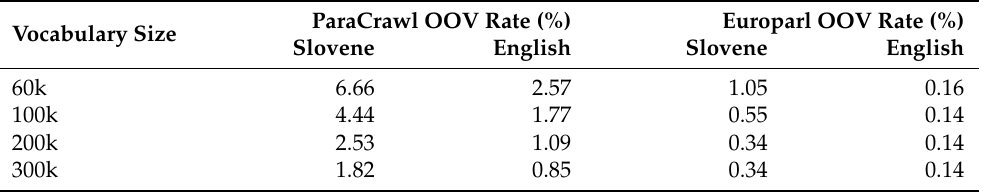
Table 5. Out-of-vocabulary rates on both corpora for differently sized vocabularies.